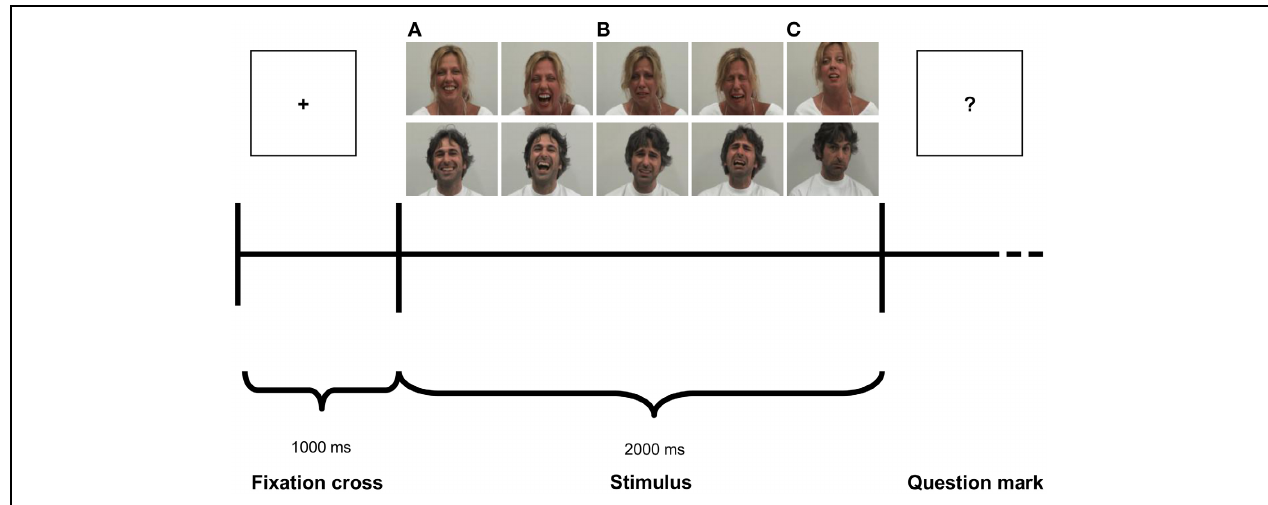
FIGURE 1 | Experimental paradigm. Photographs illustrate examples of stimuli depicting Laugh (A) , Cry (B) and Control (C)